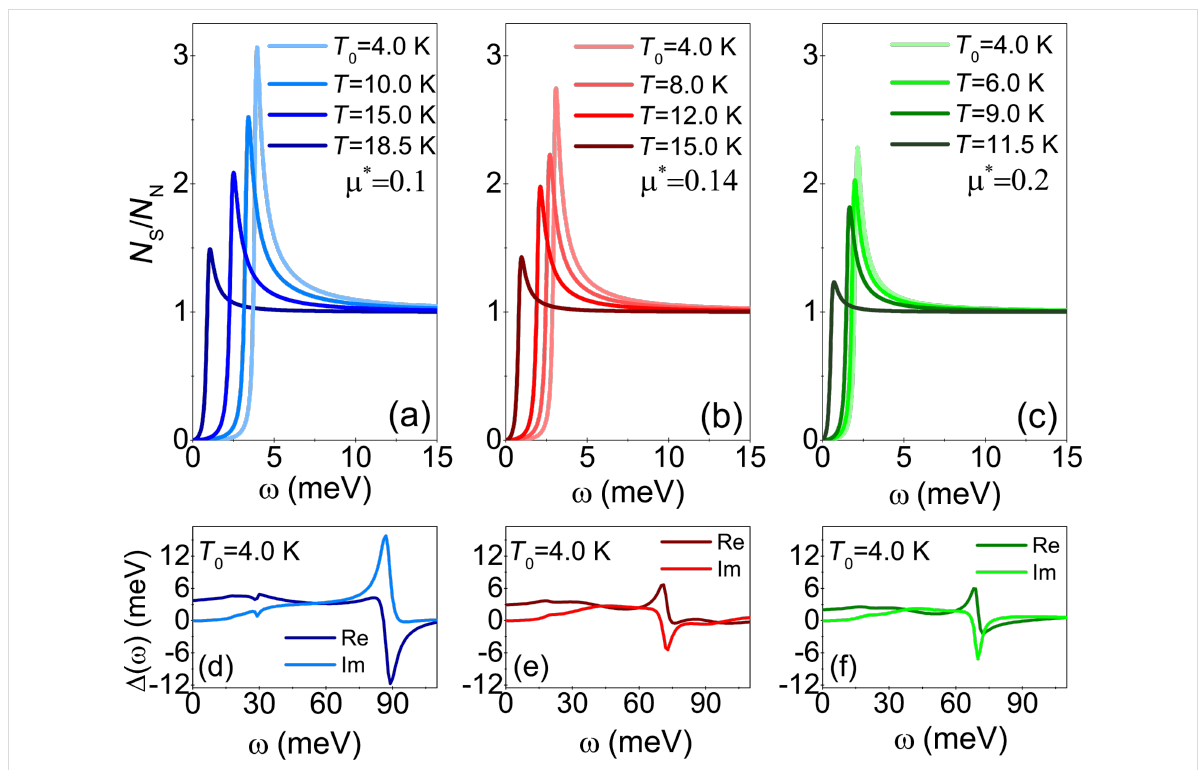
Figure 3: (a–c) Normalized density of states for the given temperatures. (d–f) The form of the order parameter on the real axis calculated for T = 4 K. The results were obtained in the framework of the LOVC